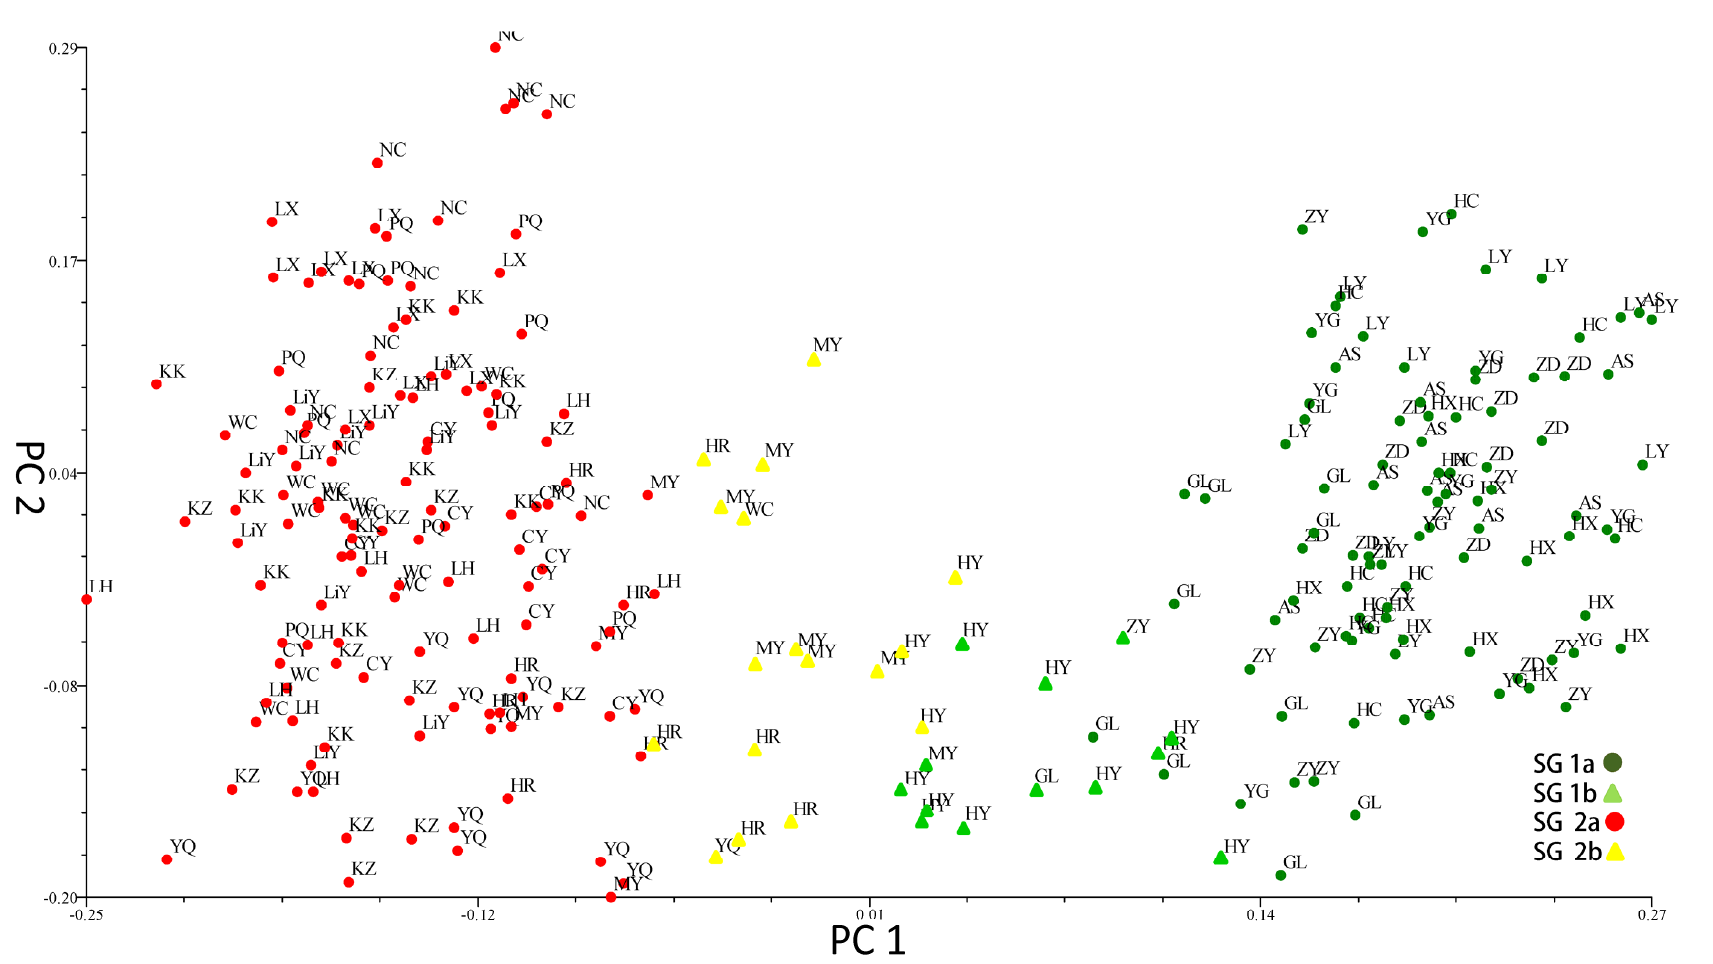
Figure S2. Principal component analysis on combined three markers data sets of the entire